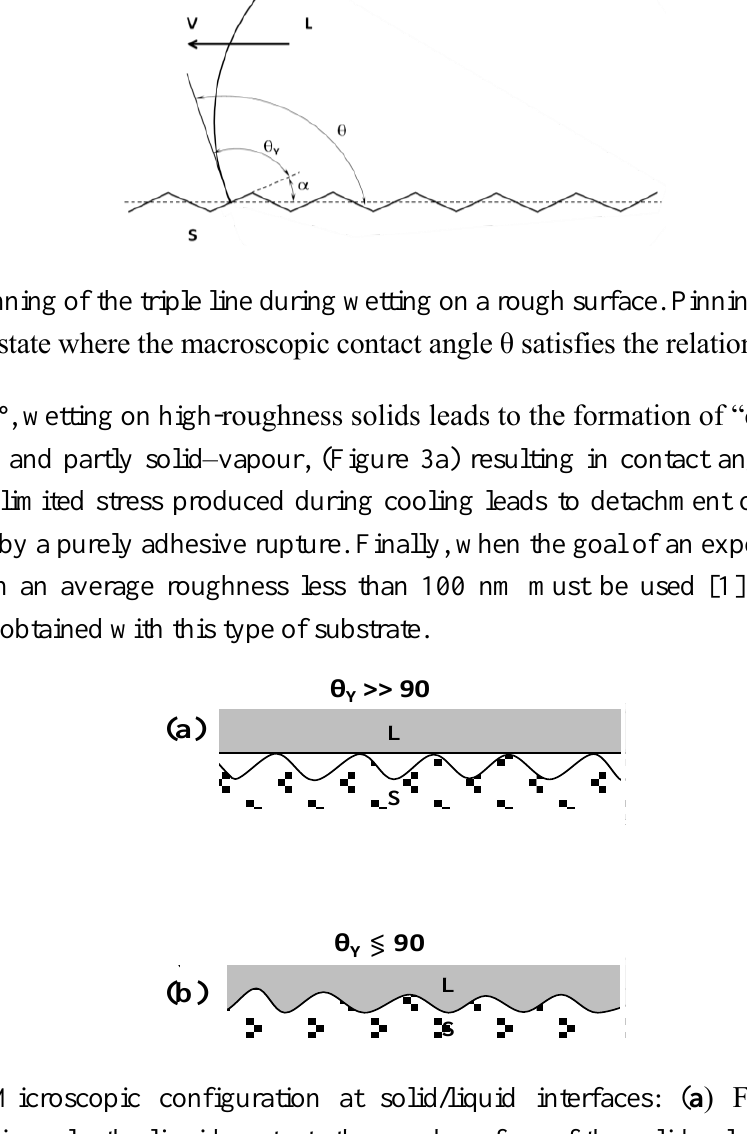
>> 90 ° , at microscopic scale, the Y